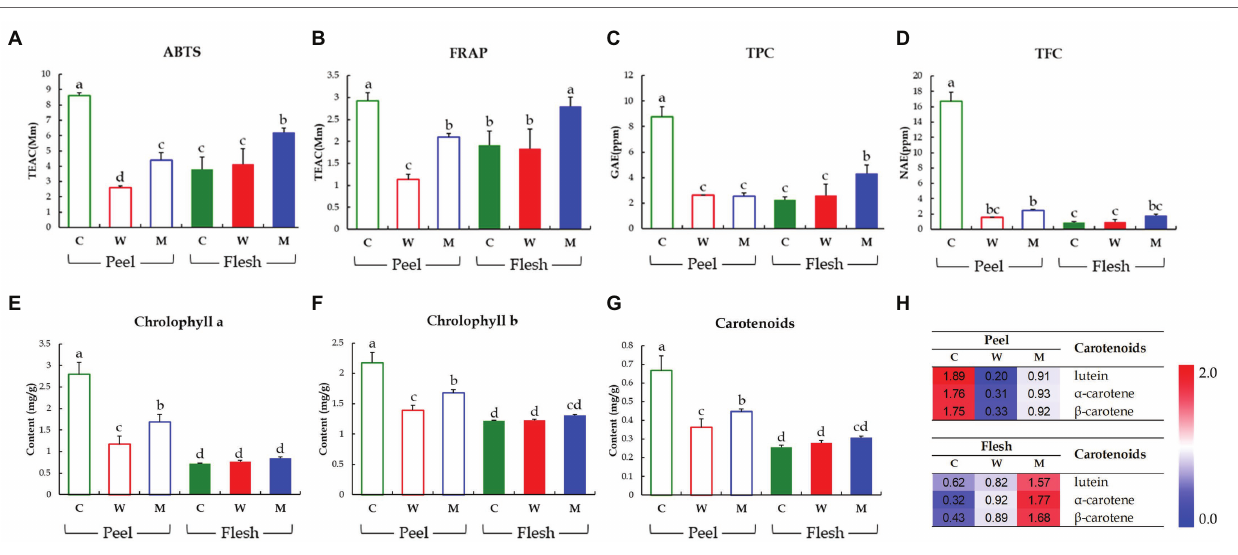
FIGURE 3 | Results of antioxidant activities including ABTS assay ( A ) and FRAP assay ( B ), TPCs ( C ), TFCs ( D ), chlorophylls contents ( E, F ), and carotenoid analysis ( G, H ). Different letters in the bar graph indicate significant difference by ANOVA followed by Duncan’s multiple-range test ( p < 0.05). ABTS, 2,2 ′ -azino-bis (3-ethylbenzothiazoline-6-sulfonic acid); FRAP, ferric reducing antioxidant power; TEAC, trolox equivalent antioxidant capacity; GAE, gallic acid equivalent concentration; NAE, naringin equivalent concentration; C, Chuichung; W, White Dadagi; M,